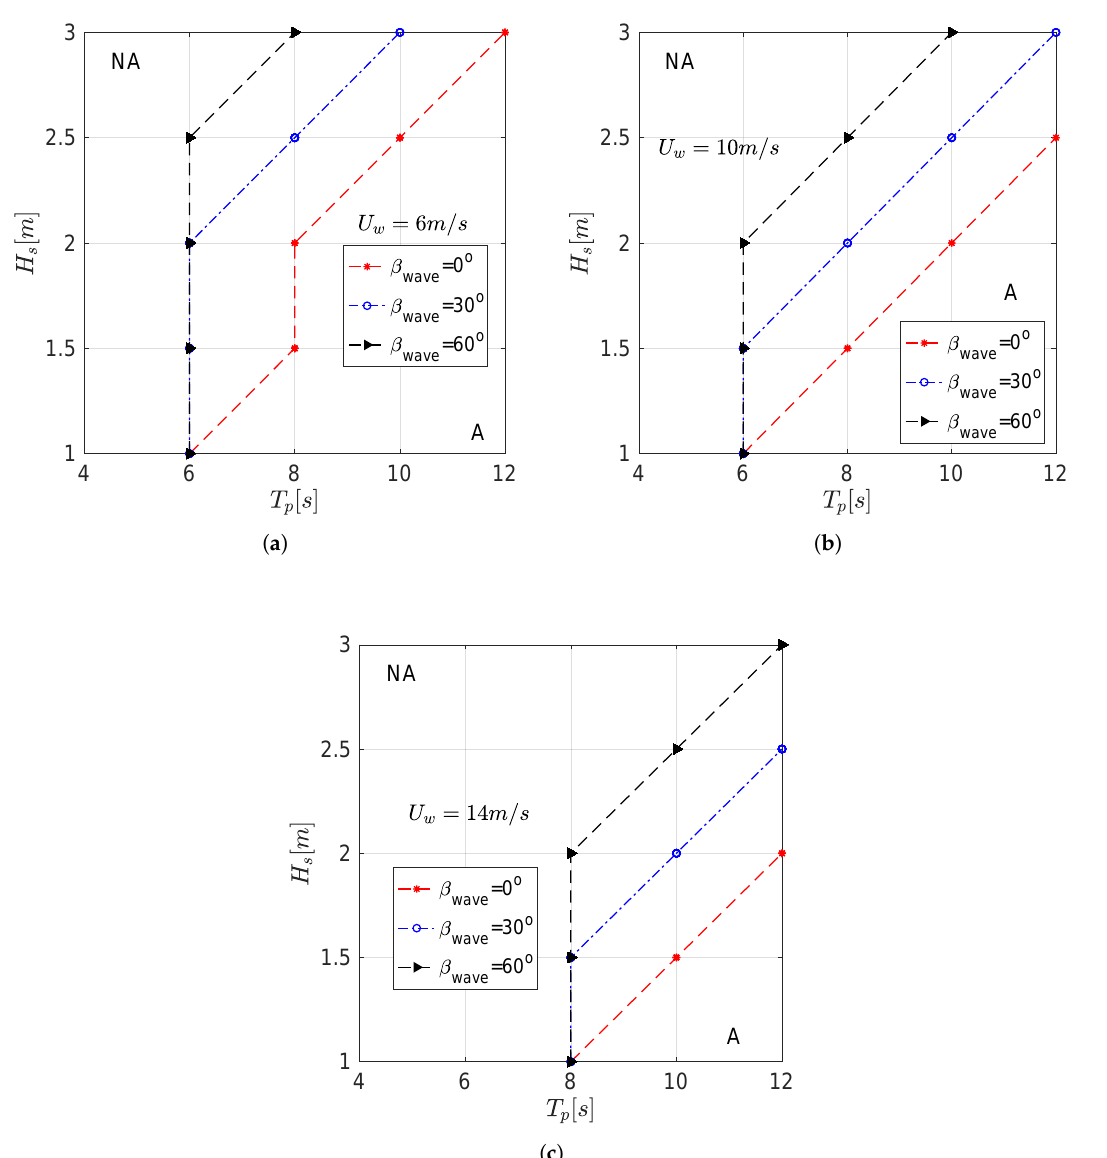
Figure 16. Operational limiting sea state curves for different H s , T p , U w , β wave = 0°, 30°, 60° with specific: ( a ) U w = 6 m/s ( b ) U w = 10 m/s ( c ) U w = 14 m/s (A: Acceptable domain and NA: Not acceptable domain for the mating